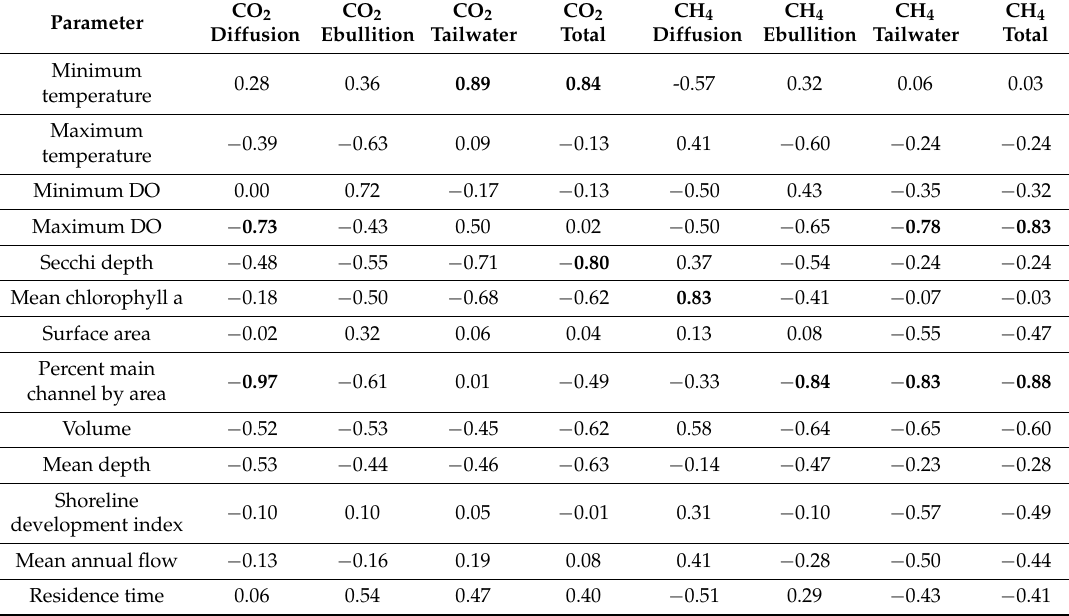
Table 4. Pearson correlation coefficients between areal emissions of CO 2 and CH 4 (mg ¨ m ´ 2 ¨ day ´ 1 ) by diffusion, ebullition, and tailwater pathways and selected properties of the hydropower